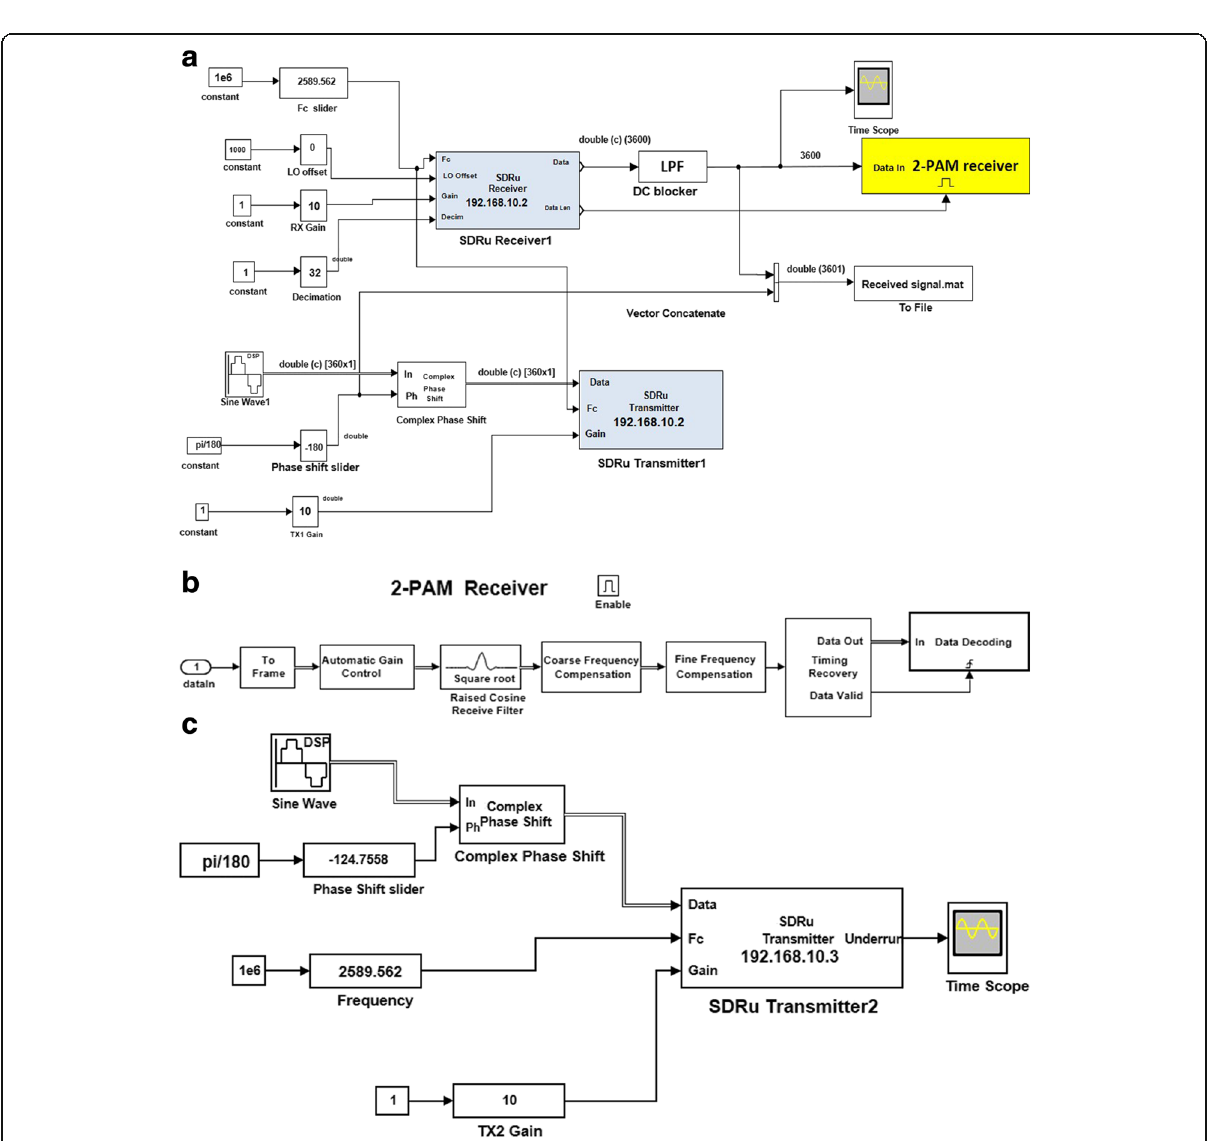
Fig. 8 Matlab Simulink block diagram for the backscatter M-query scheme using USRP N210 a implemented USRP No.1 as the transmitter and receiver b 2-PAM non-coherent receiver chain for the backscattered data extraction c transmitter module USRP No.2 with phase tunning